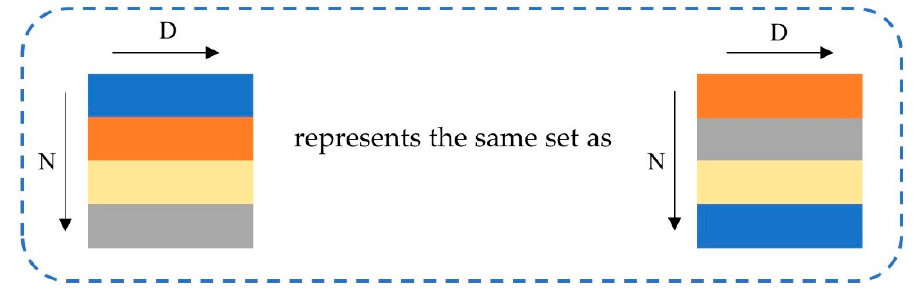
Figure 5. Disorder characteristics of data.